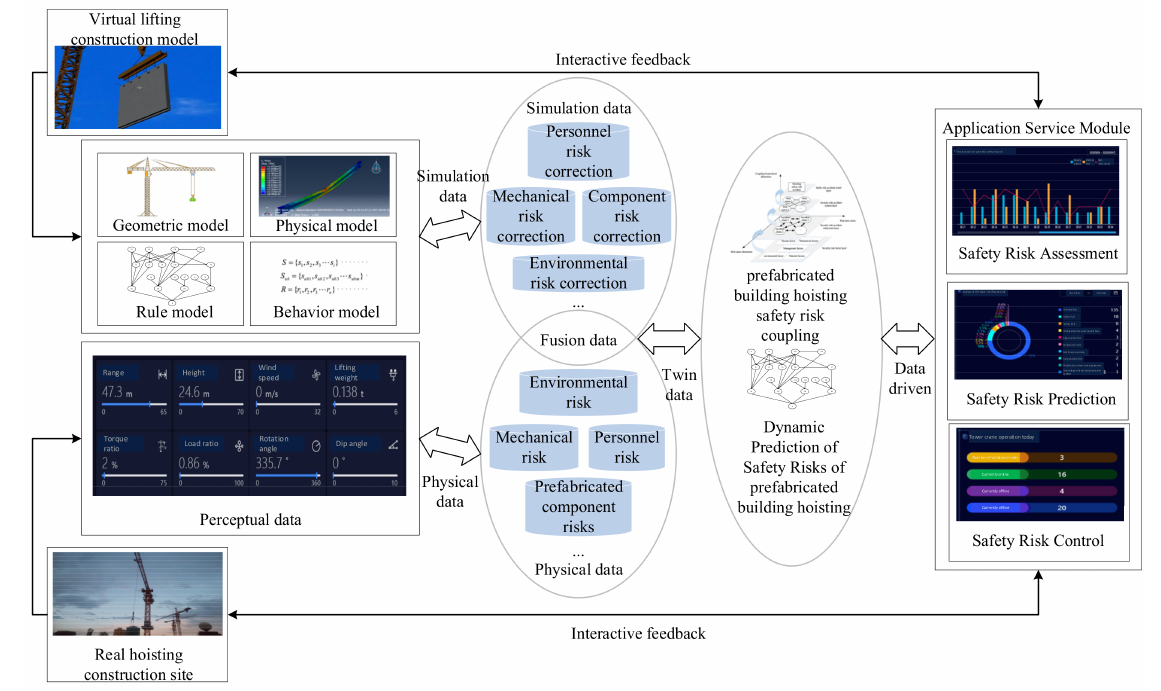
Figure 1. Framework for DT-based safety risk management of prefabricated building hoisting.